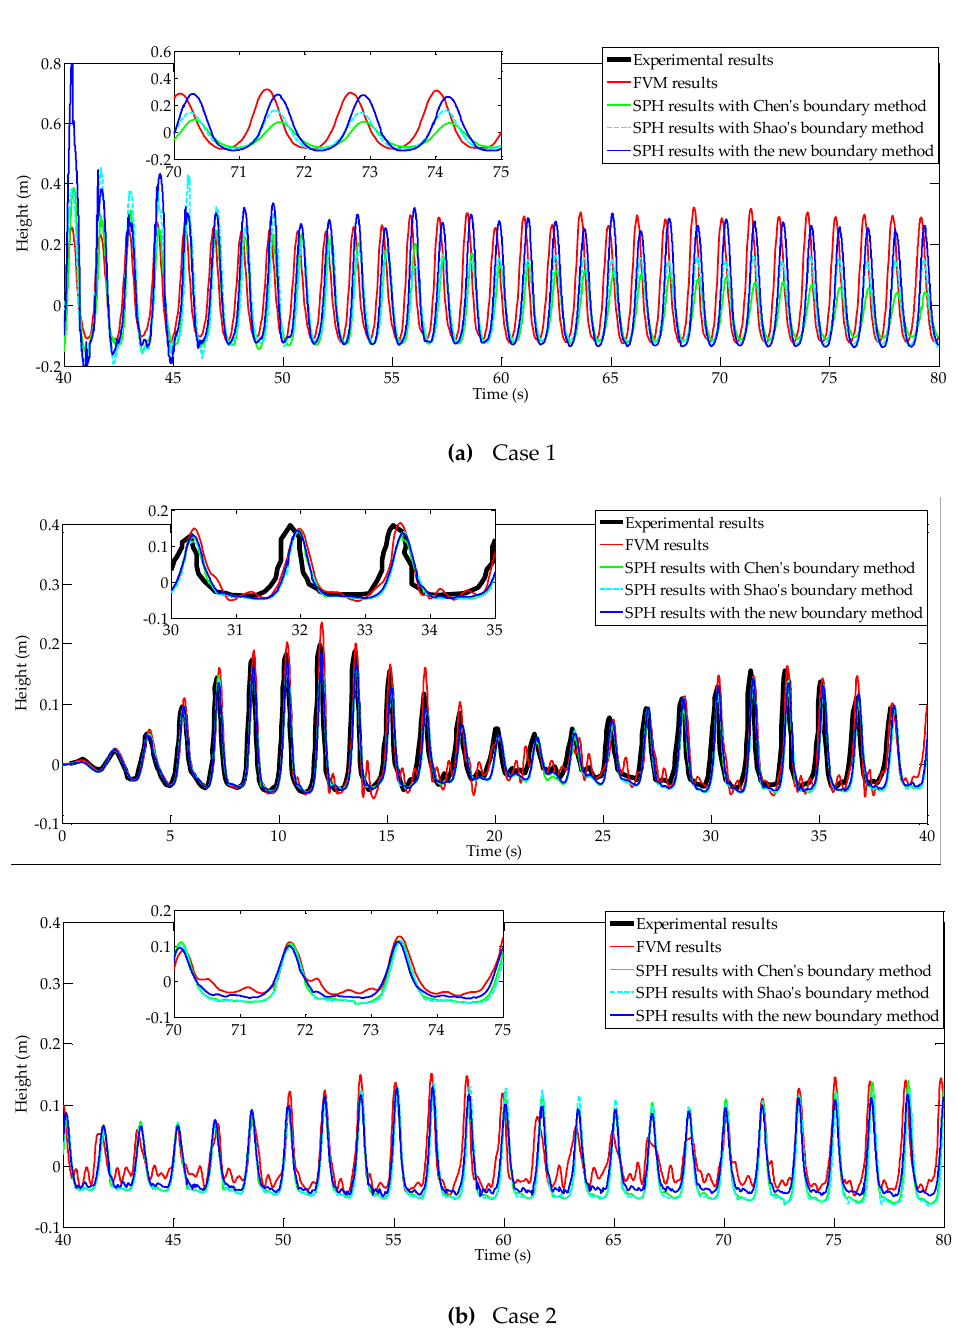
Figure 6. Wave elevation at the wave gauge obtained by the numerical simulations and experiment of ( a ) Case 1 and ( b ) Case 2.